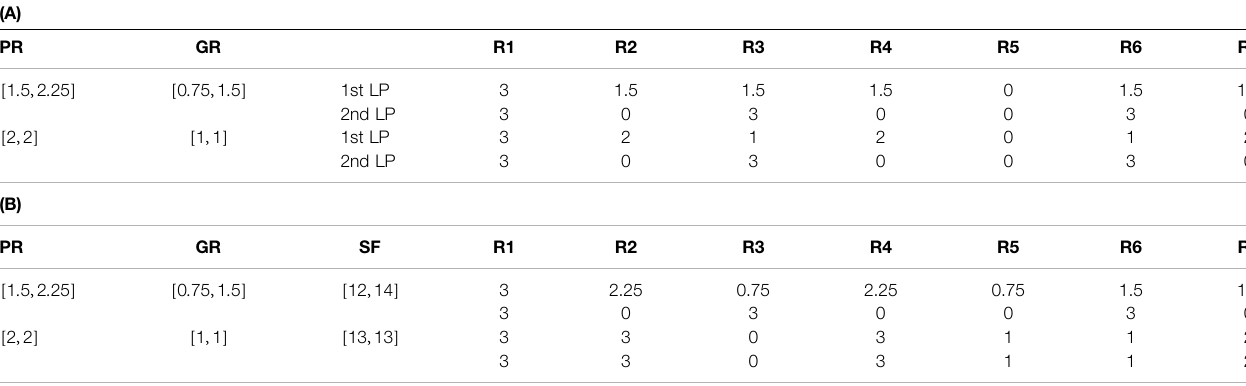
TABLE 2 | (A) GridProd cannot fi nd reaction deletion strategies that achieve growth coupling for the toy example of Figure 2A even when P is in fi nity. (B) However, CubeProd can fi nd reaction deletion strategies for the same